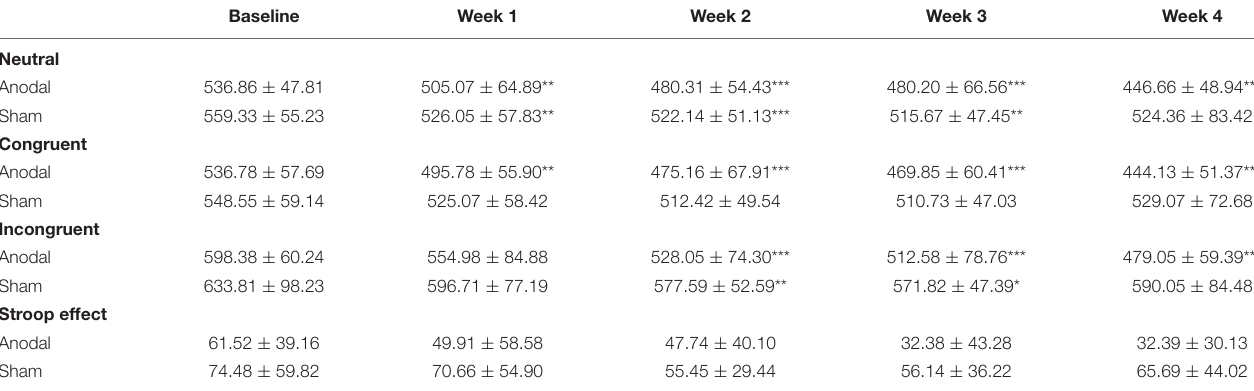
TABLE 4 | Mean reaction time on three conditions of CW-Stroop and Stroop effect from baseline to week 4 in the anodal and sham groups. Baseline